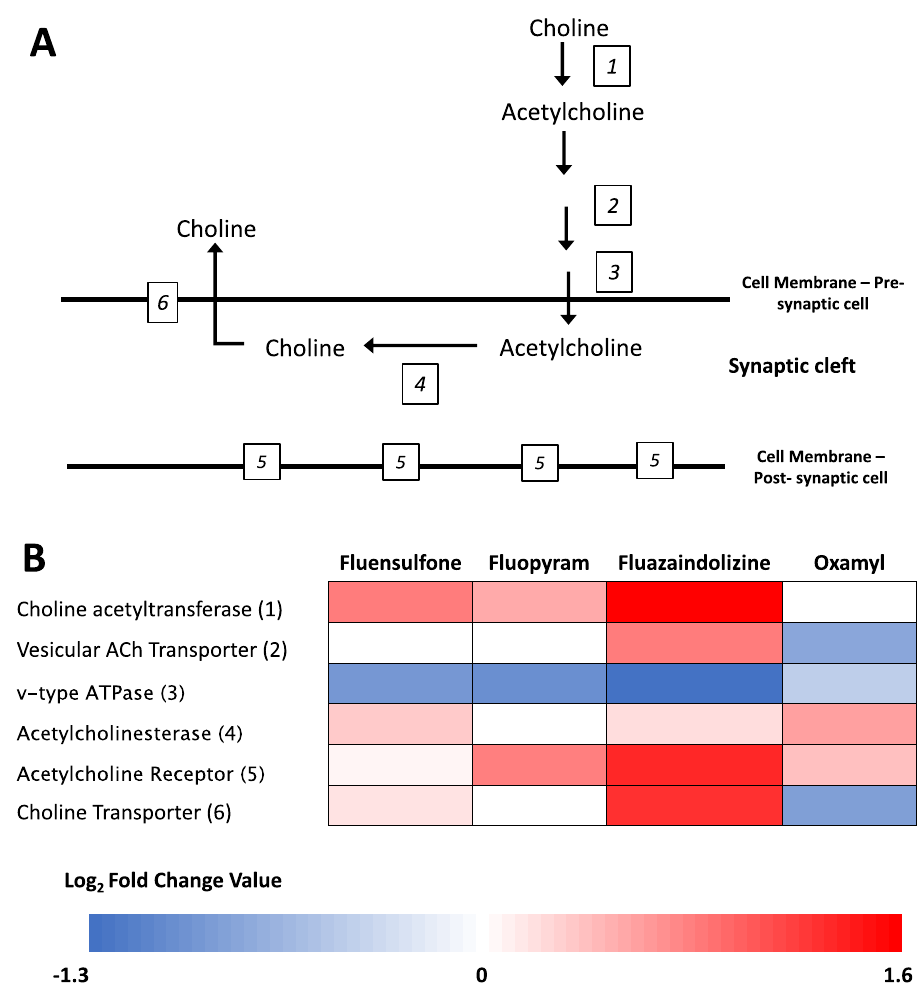
Figure 2. Gene expression summary of acetylcholine neuron components in Meloidogyne incognita after nematicide exposure. Meloidogyne incognita second-stage juveniles were exposed to fluensulfone, fluopyram, fluazaindolizine, and oxamyl for 24-h and high throughput sequencing used to determine gene expression compared to a water treated control (N = 4 replicates per treatment). Expression is in the form of Log 2 Fold Change (Log 2 FC); red and blue indicate upregulated and downregulated expression compared to control, respectively. Each Log 2 FC value represents the arithmetic mean of expression of significantly ( P < 0.05) differently expressed genes that were identified as that enzyme in M. incognita . The enzymatic steps involved in acetylcholine neuron potential are outlined in panel ( A ), with the corresponding expression to each step in panel ( B